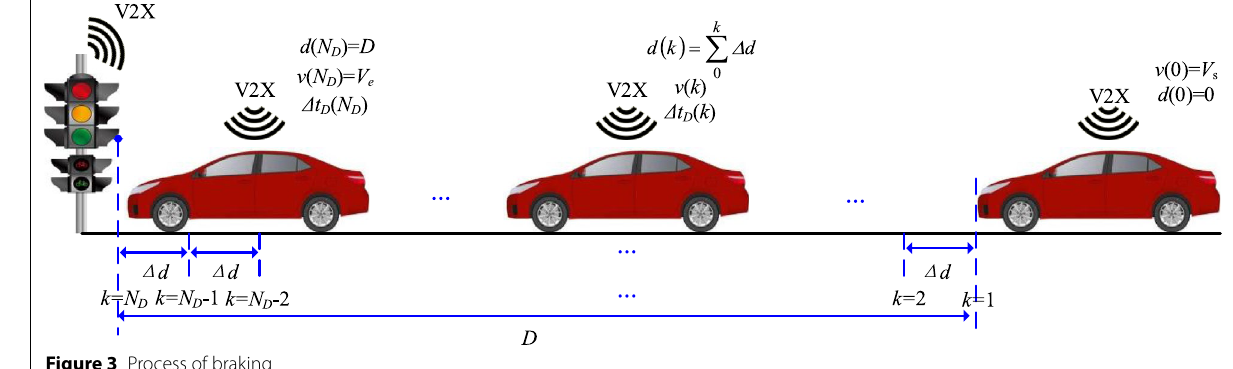
Figure 3 Process of